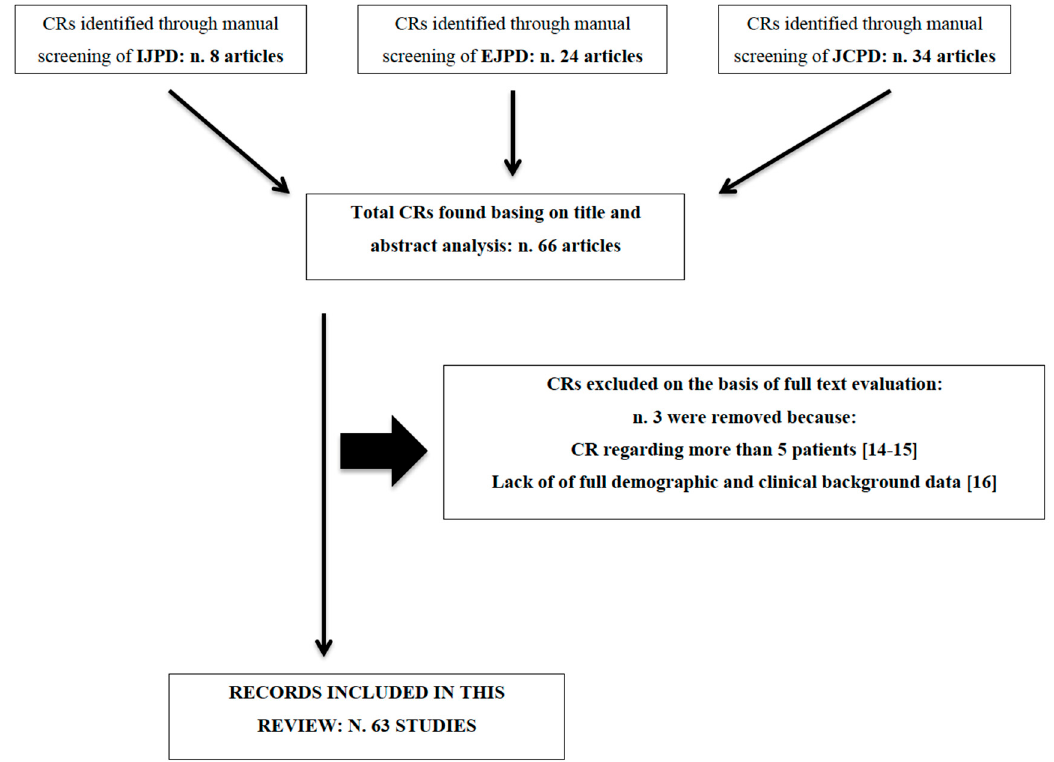
Figure 1. Flow chart of the search strategy. CR = Case Report; IJPD = International Journal of Paediatric Dentistry; EJPD = European Journal of Paediatric Dentistry; JCPD = Journal of Clinical Pediatric Dentistry [14–16].